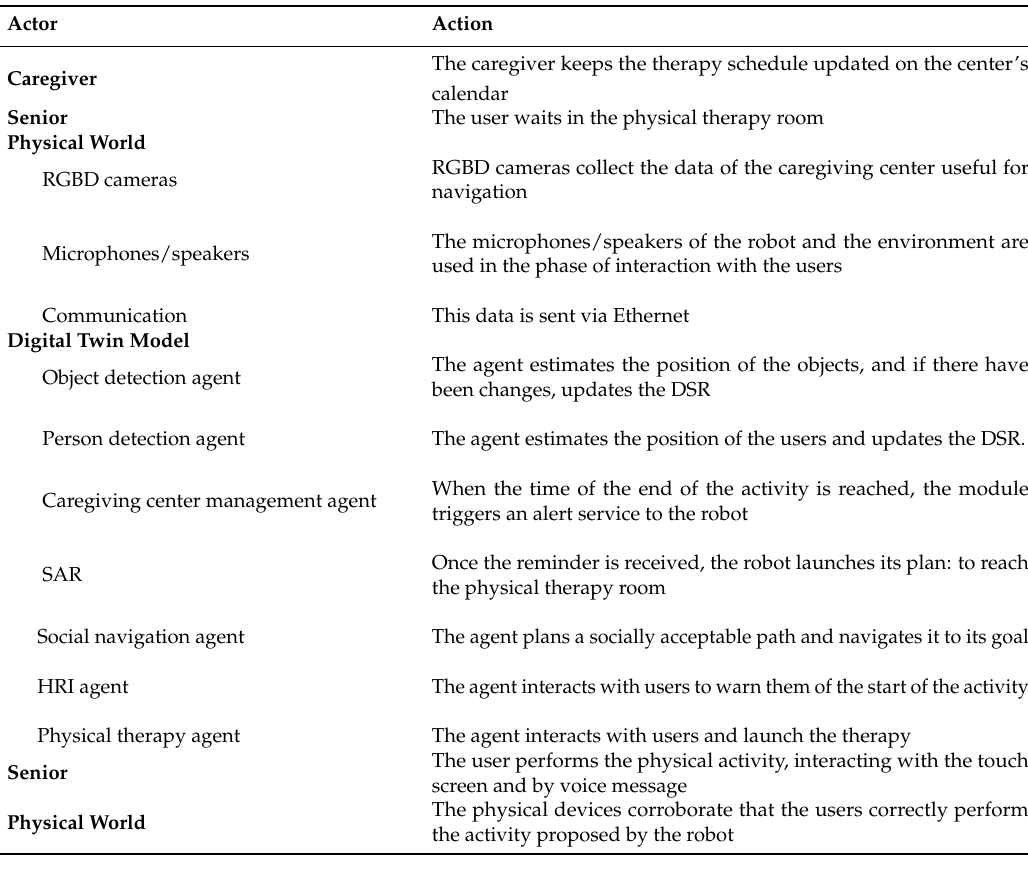
Table 3. Use case 2: The robot acts as a virtual physical therapist that navigates to the user and proposes a physical